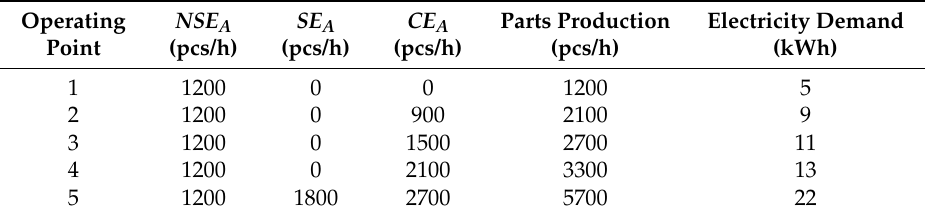
Table 1. Operating points of the automatic cutting system (ACS) during each time interval.